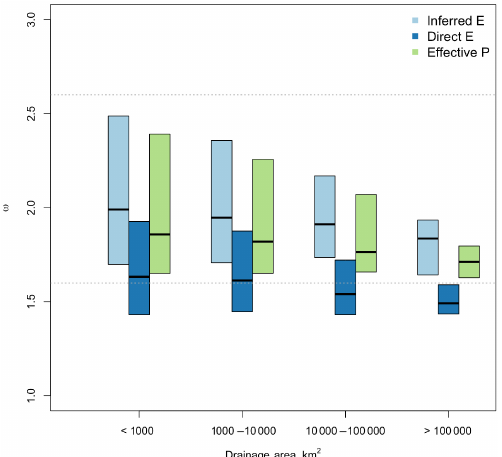
Figure 11. Box plots showing the interquartile range (i.e., 25– 75th percentile values) of shape parameters for all three approaches grouped by drainage area. Dashed lines are at 1.6 and 2.6 for refer-